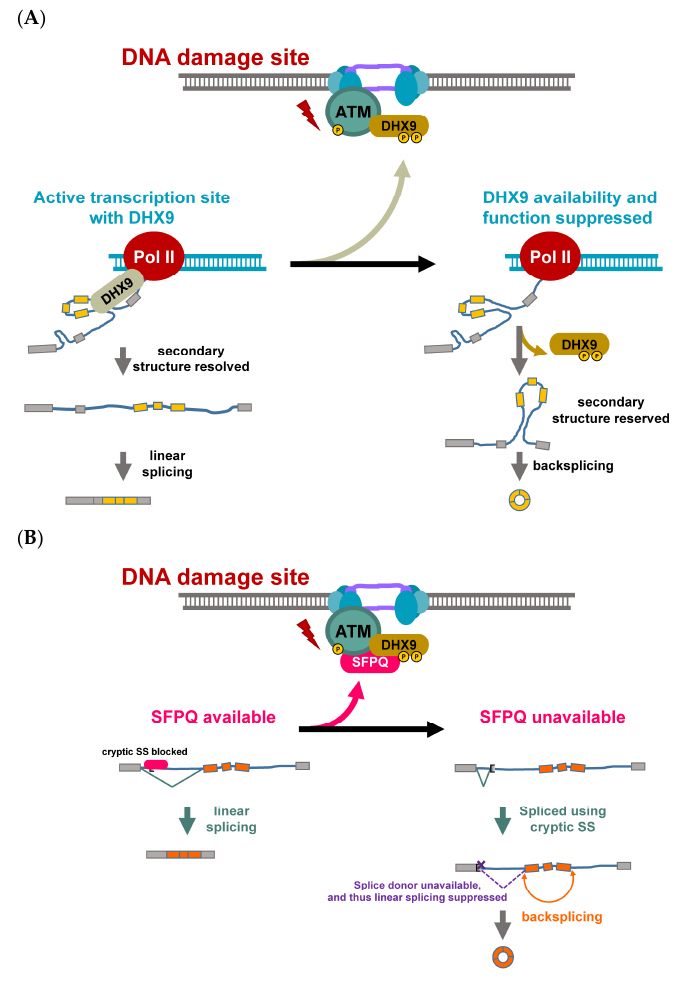
Figure 2. DNA damage response controls the function and availability of RBP for regulation of backsplicing. ( A ) In the absence of DNA damage, DHX9 works with transcription machinery for resolving the secondary structure of nascent RNA, and thereby keeps a low frequency of backsplicing (bottom left). Upon double-stranded DNA breaks (top), the PI3KKs (ATM for example) are recruited to the damage sites, accumulated and autophosphorylated for its maximal kinase activity and for recruiting other DDR proteins. DHX9 is recruited to the damage site and becomes phosphorylated near to its double-stranded RNA binding domain, hindering its binding to the double-stranded RNA substrate. The unresolved pairing between upstream and downstream introns allows the backsplicing to take place (bottom right). ( B ) In a similar fashion, SFPQ forms a complex with DHX9 upon genotoxic stress. When SFPQ sits on the cryptic splice site in the upstream intron of circular- izable exons (orange boxes), SFPQ suppresses the linear splicing, which uses the cryptic site (bottom left). However, when SFPQ becomes unavailable due to genotoxic stress-induced relocation to DNA damage sites, the splicing uses up the splice signal, making backsplicing the only option for the rest of the molecule (bottom right).